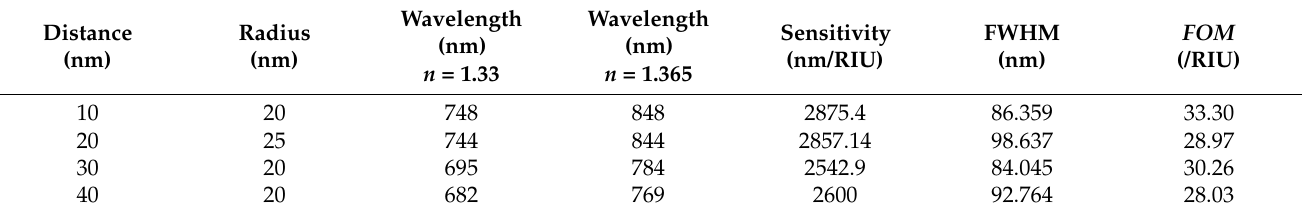
Figure 8. Sensitivity and FOM for the different combinations of the nanosphere radius and distance between nanospheres, ( a ) distance of 10 nm, ( b ) distance of 20 nm, ( c ) distance of 30 nm and ( d ) distance of 40 nm. Table 1. Evaluation of the sensing performance for the sensors with different thicknesses and distances between SiO 2 nanospheres.